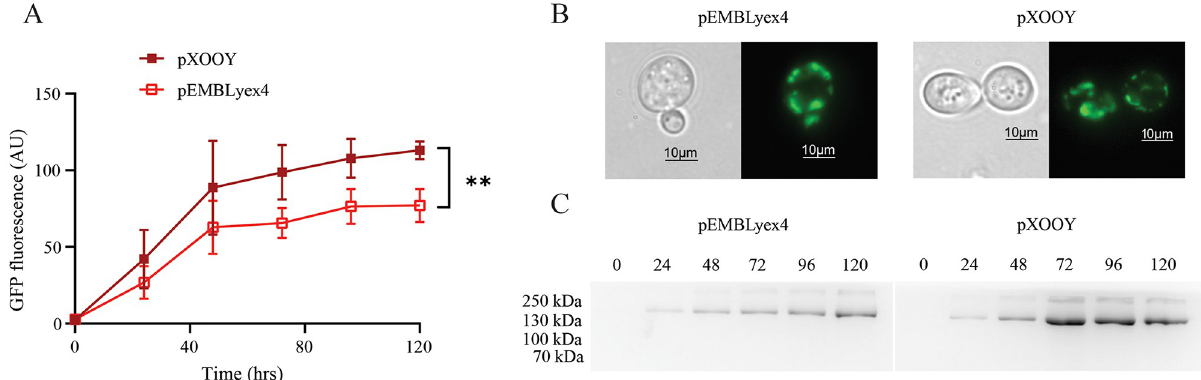
Fig 5. Accumulation of ohERG-TEV-yEGFP-His 10 in S . cerevisiae . (A) Fluorescence in 1 OD 450 unit as a function of time after induction of ohERG-TEV-yEGFP-His 10 production with galactose. The dark red curve and the bright red curve show average fluorescence accumulation in PAP1500 cells expressing ohERG-TEV-yEGFP-His 10 from pXOOY or pEMBLyex4, respectively. Averages were calculated from four repetitions of the experiment and error bars indicate ± S.D. The accumulation curves were compared using a two-way ANOVA test where �� p = 0.0056. (B) Light microscopy (DIC) and fluorescence microscopy bio-imaging shown pairwise of yeast cells expressing either ohERG-TEV-yEGFP-His 10 from pEMBLyex4 (left) or pXOOY (right). (C) In-gel fluorescence from crude yeast membranes isolated from cells harvested at the indicated time points after induction with galactose. The left gel shows 25 μ g crude membrane samples from cells expressing ohERG-TEV-yEGFP-His 10 from pEMBLyex4 and the right gel shows 25 μ g membrane samples from cells expressing the same protein but from pXOOY. The two gels were imaged simultaneously. Uncropped gels can be found in S1, S2 Figs.